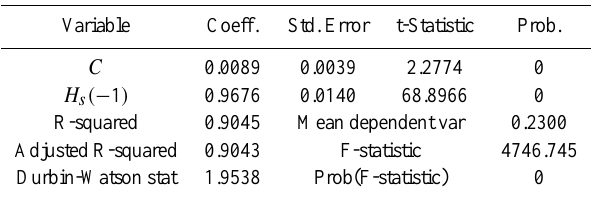
Figure12. Significant wave height auto correlation with 1hr time lag Fig. 12. Significant wave height autocorrelation with 1-h time